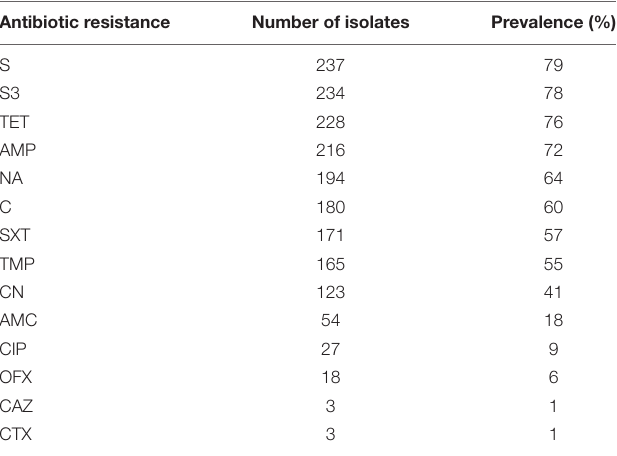
TABLE 3 | Prevalence of antibiotic resistance among 300 Salmonella Typhimurium isolates. Antibiotic resistance